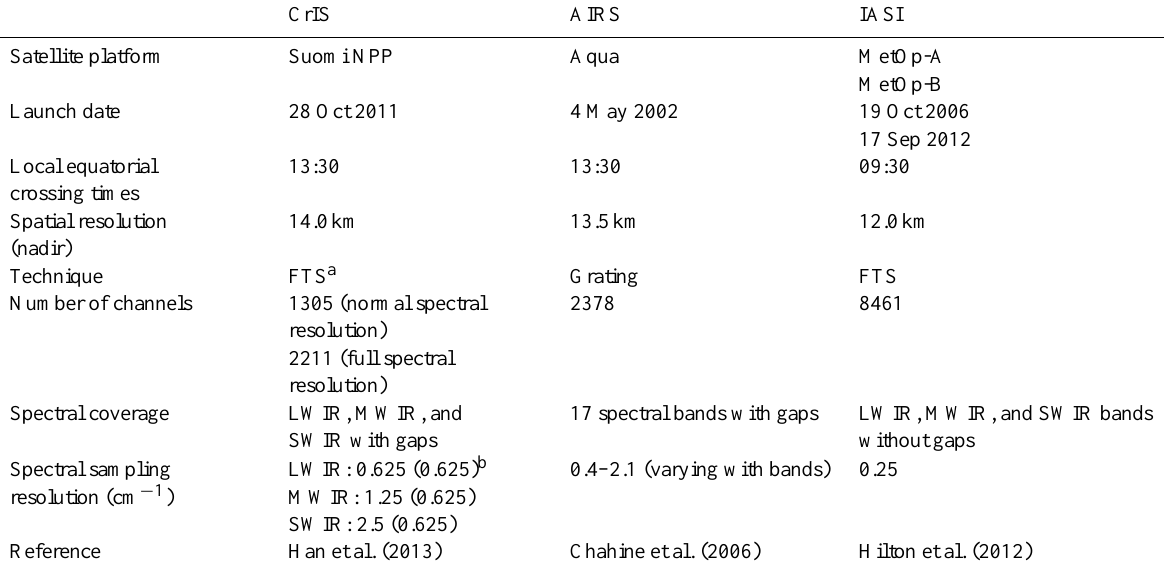
Table 1. Instrument characteristics of CrIS, AIRS, and IASI.